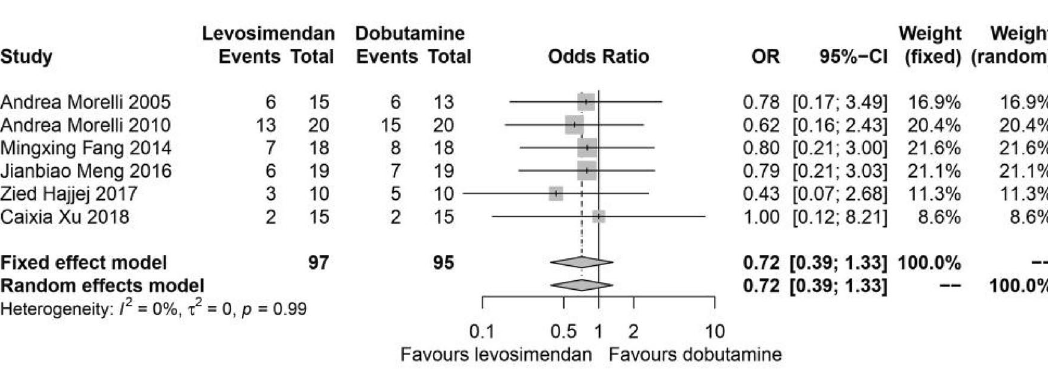
Figure 4. Clearance of serum lactic acid. SD standard deviation; MD mean difference; CI confidence interval.